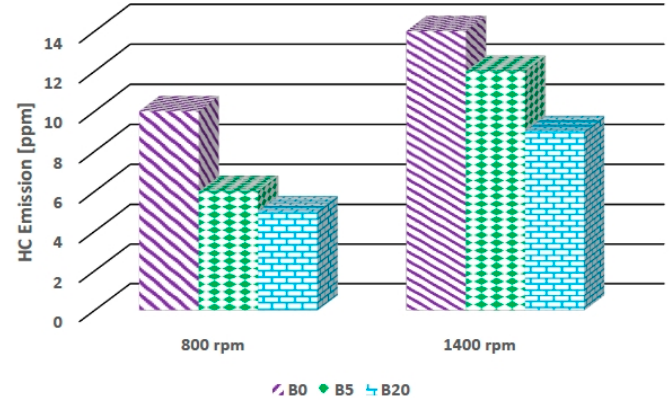
Figure 9. Variation of hydrocarbon emission with speeds.